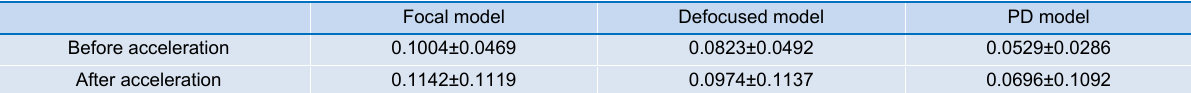
Table 5 | Summary of accuracies (Root Mean Square Error (RMSE):λ) of Zernike coefficients estimated by PD-CNN. The focal model and PD-CNN includes both focal and defocused image. Table reproduced from: (a, b) ref. 82 , MDPI.